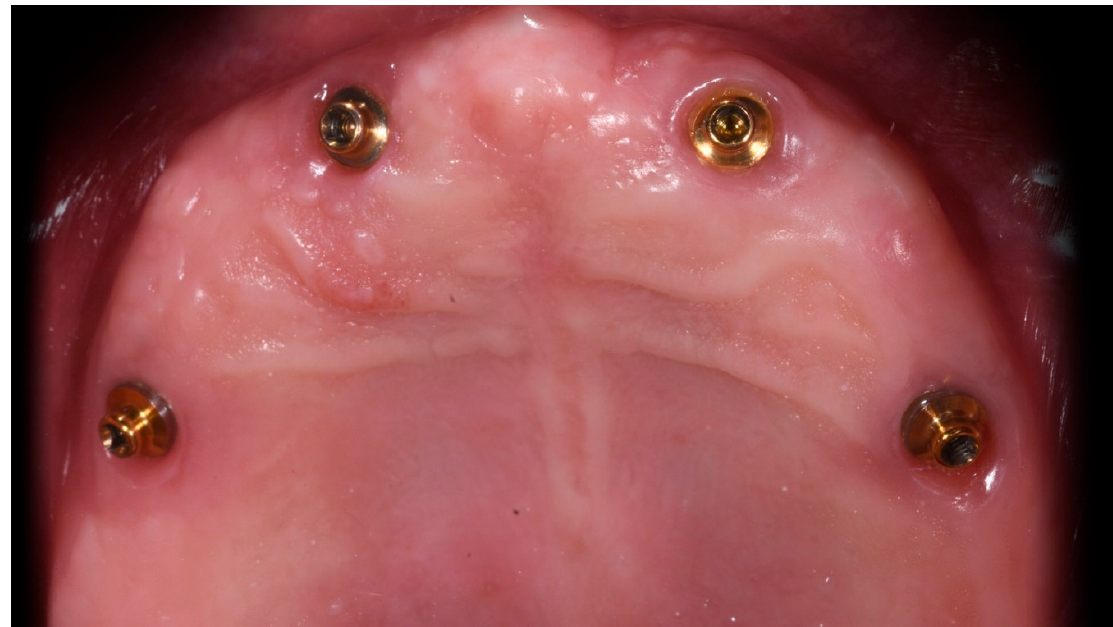
Figure 4. OT Equator mounted in the mouth.